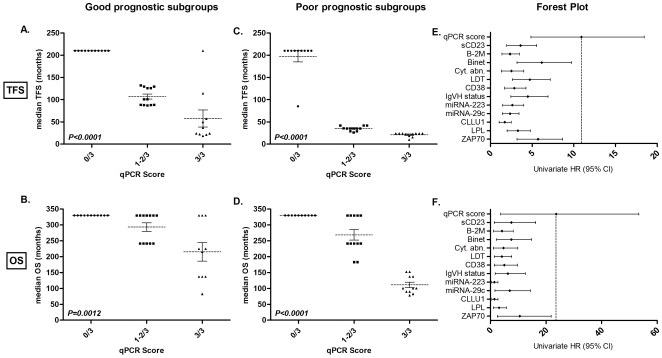
Supplementary prognostic value of the qPCR score.Each prognostic factor was used to divide the patient cohort in two different prognostic subgroups according to prognostic factors reported in Table 1. The qPCR score was then applied to all poor prognosis subgroups and good prognosis subgroups. (A) and (B) show the median TFS and median OS of the good prognosis subgroups, whereas (C) and (D) show the median TFS and median OS of the poor prognostic subgroups. The dotted line and error bar represent the mean and the SEM, respectively. Statistical differences were assessed using the Kruskal-Wallis test. Parts (E) and (F) show forest plots comparing the univariate Cox HR of the qPCR score with other prognostic factors for TFS and OS prediction, respectively. The hazard ratio (HR) of all variables was calculated by univariate Cox analysis and plotted with the 95% Cl on this forest plot. More details can be found in Table 2.